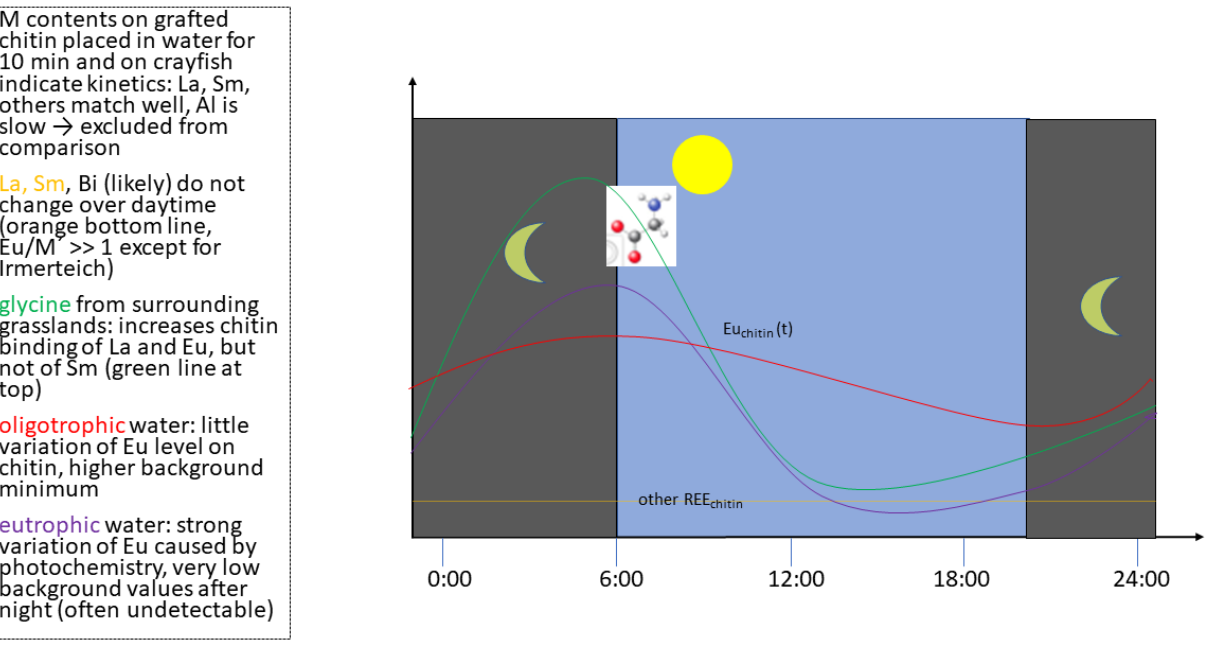
Figure 16. Predicted variation of Eu bound to chitin with and without glycine, potential substrates of Eu-mediated photooxidation over daytime. Sampling was conducted int the morning at dawn [32].